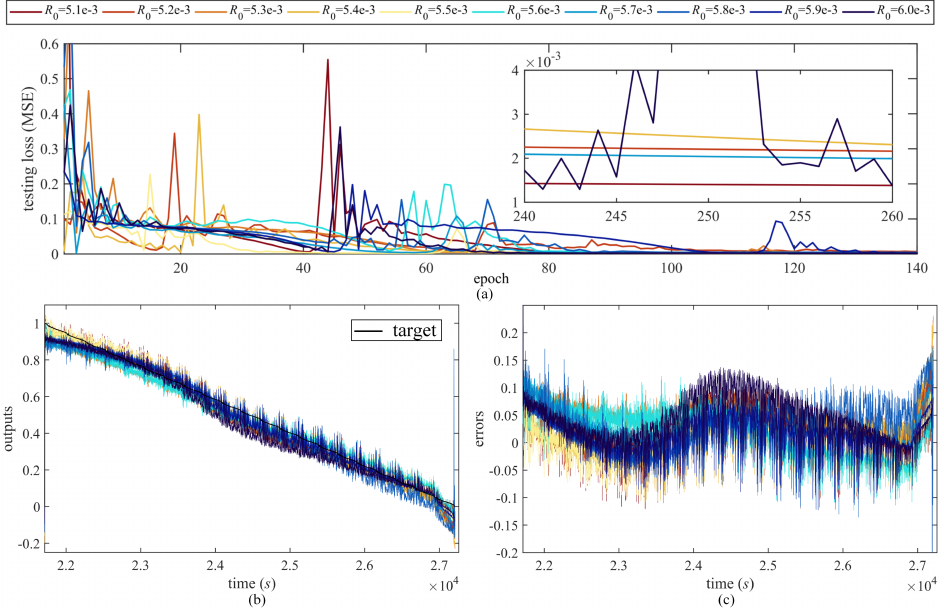
Figure 14. Sensitivity of the ohm resistance R 0 in battery FOM for fractional-order PDE